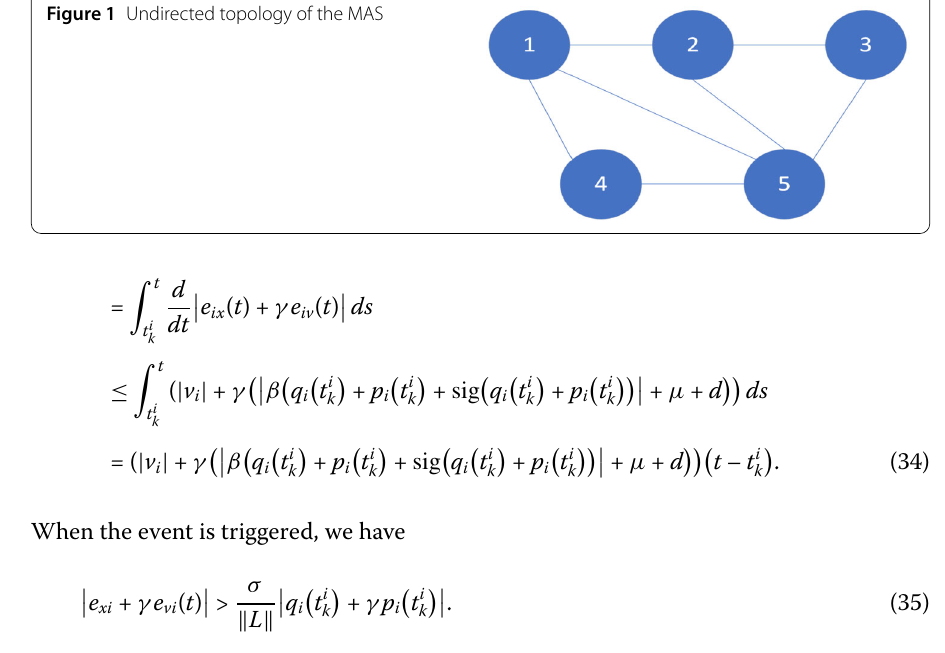
Figure 1 Undirected topology of the